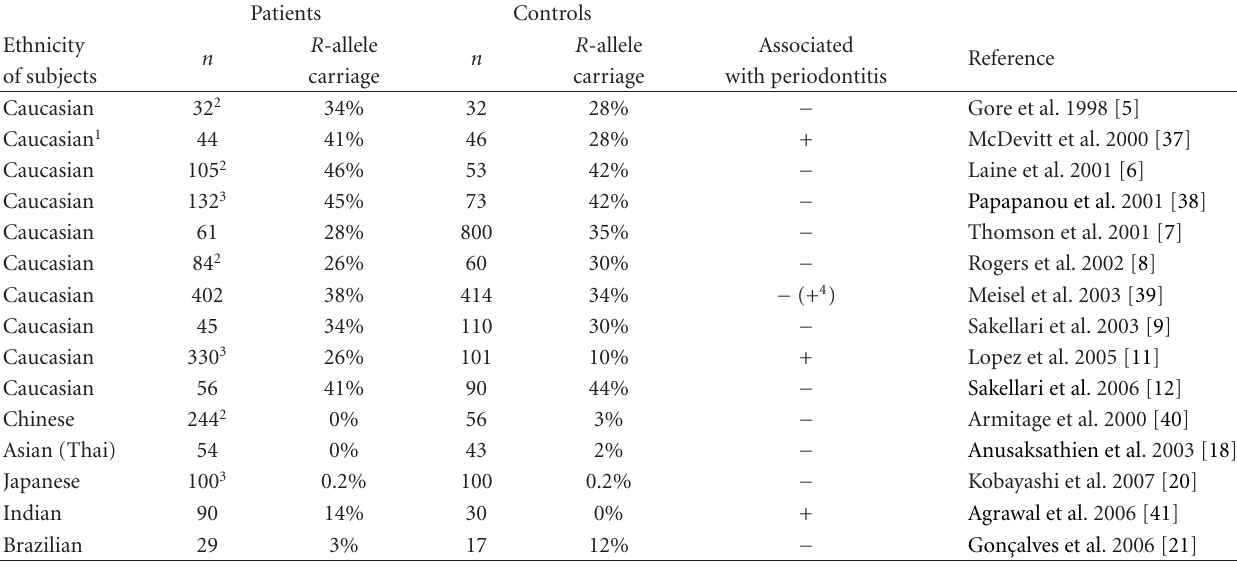
Table 4: IL1 composite genotype, that is, Rare (R )-allele carriage at IL1A -889 (+4845) and IL1B +3954 (+3953) [36], in case-control studies and association with susceptibility to chronic